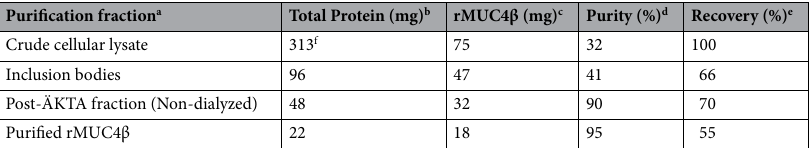
Table 1. Purification of rMUC4β from E. coli Rosetta 2(DE3). a Fractions collected during ÄKTA-FPLC. b Total protein quantified using NanoDrop One-C (Thermo Scientific). c rMUC4β concentration (mg) determined by the relative quantification of Coomassie Blue stained SDS-PAGE gels compared to a BSA standard curve using Biorad Gel Doc XR + Imaging System (BioRad). d Purity of refolded rMUC4β in each fraction obtained by dividing the rMUC4β band area (intensity) by total area (intensity) of all stained bands in the same lane. e Percent recovery or yield of rMUC4β was calculated on a “per fraction” basis by dividing the amount of MUC4β (mg) in that fraction by the amount present in the previous fraction and multiplying by 100. f Total protein from cell lysate includes both soluble and insoluble